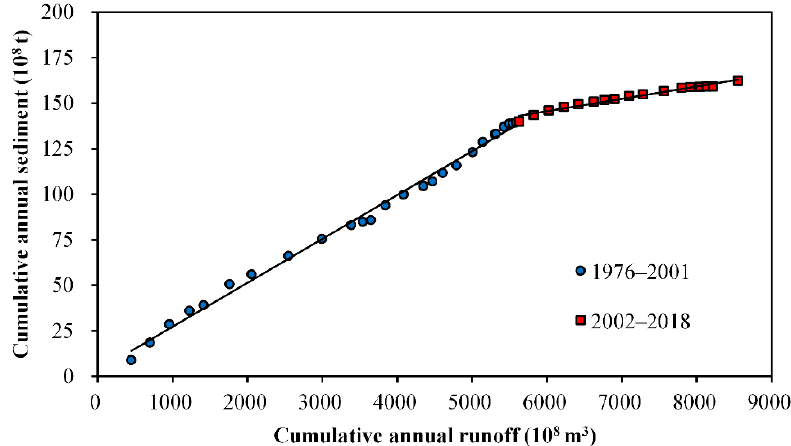
Figure 7. The relationship between the cumulative annual sediment discharge and runoff before and after water-sediment regulation.